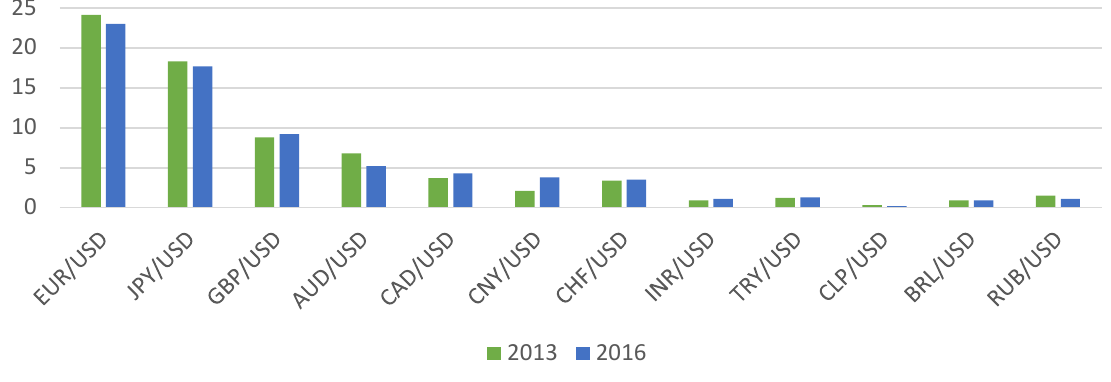
Figure 1. Foreign exchange market turnover of USD based currency